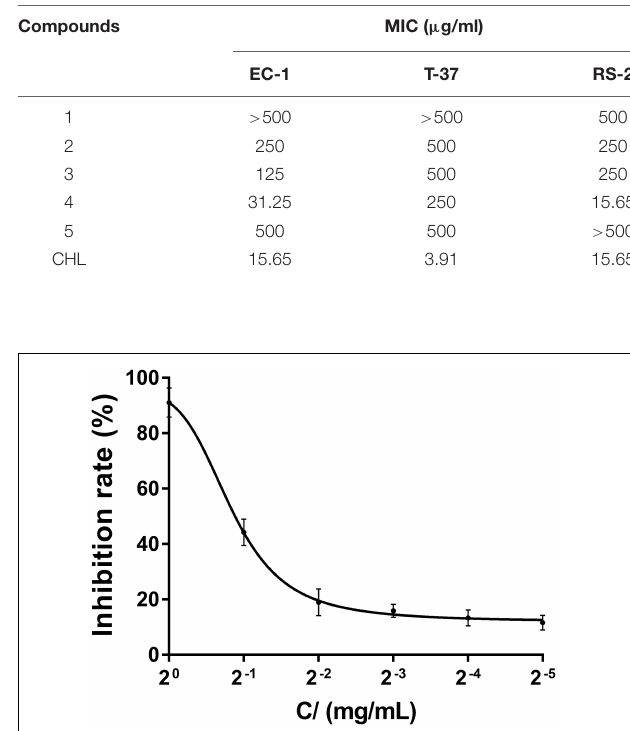
TABLE 1 | Antibacterial activities of compounds.